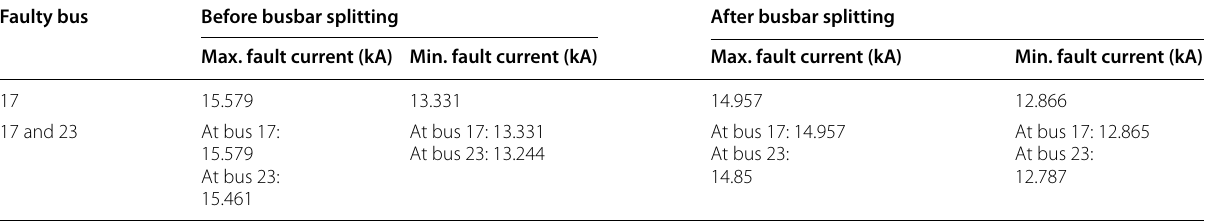
Table 6 Fault current at faulty buses before and after splitting in IEEE 30-bus system Faulty